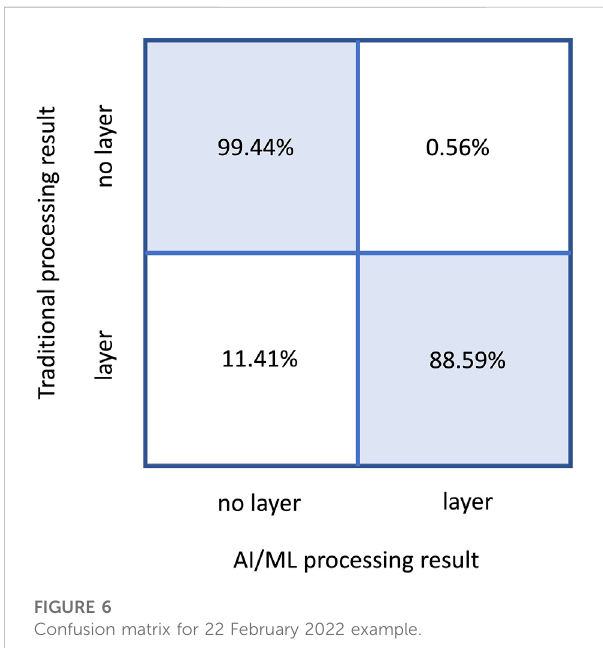
FIGURE 6 Confusion matrix for 22 February 2022